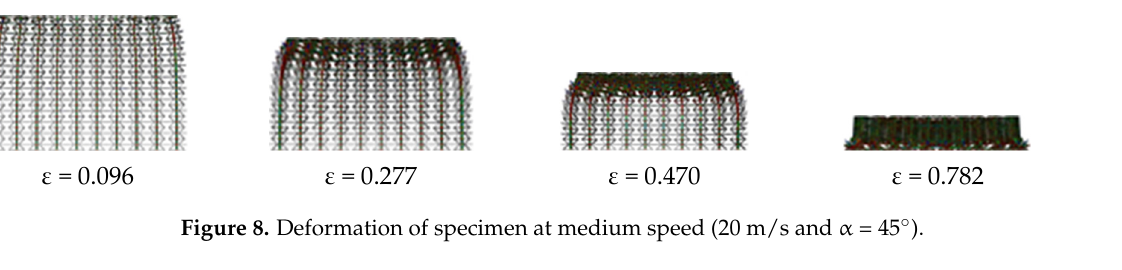
Figure 7. Deformation of specimen at low speed (3 m/s and α = 45°).